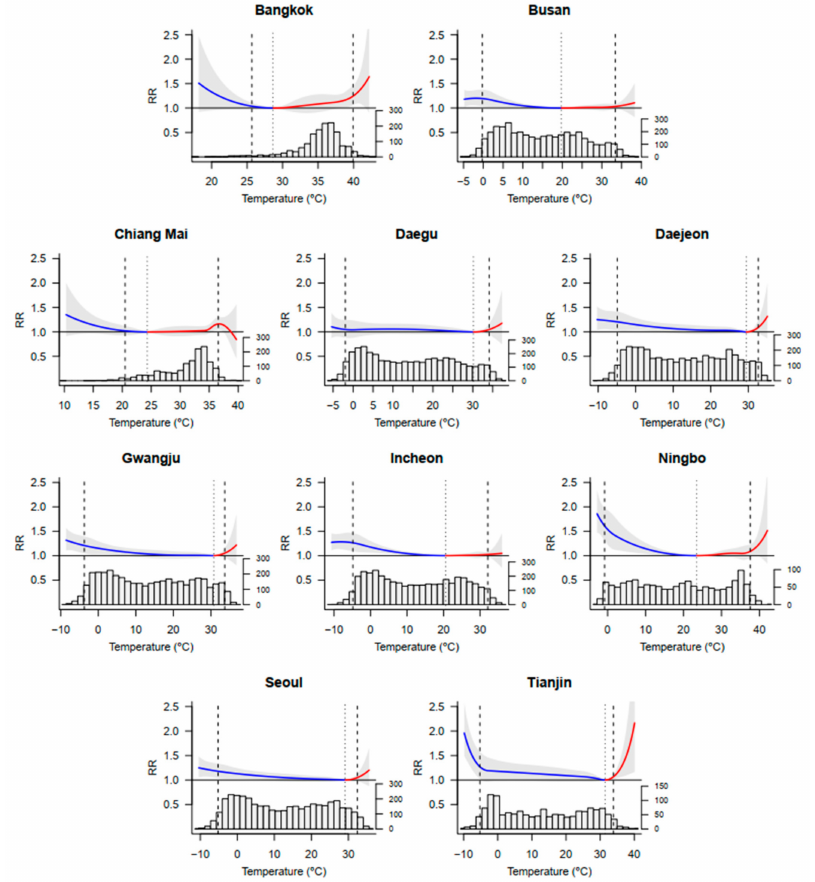
Figure 2. The overall cumulative exposure-response associations in 10 cities. Exposure-response associations as best linear unbiased prediction (with 95% empirical CI, shaded grey) in 10 countries, with related temperature distributions. Gray dotted lines are minimum mortality temperatures, and gray short-dashed lines are the 2.5th and 97.5th percentiles. RR = relative risk. Table 2. Attribution risk of the impact of short-term temperature exposure on non-accidental mortality in ten Asian cities.